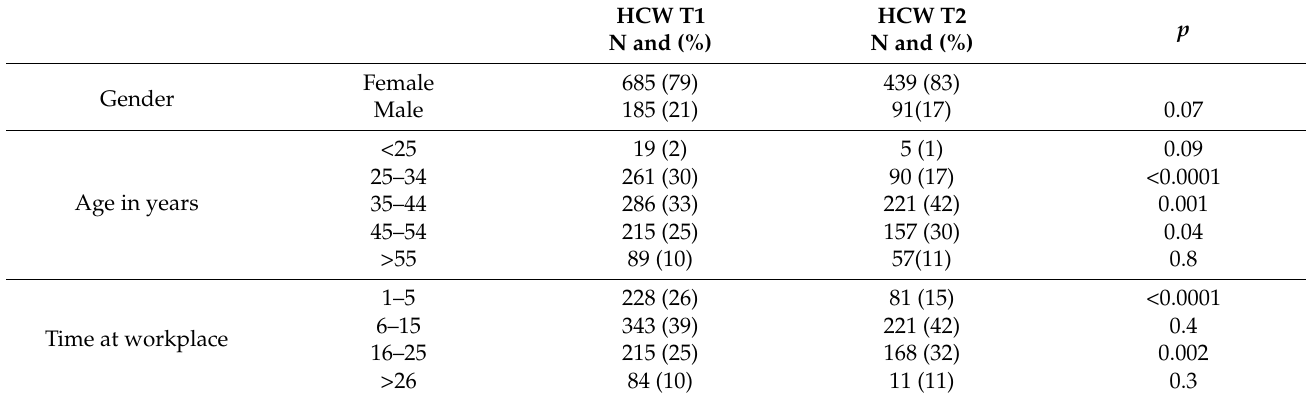
Table 3. Comparisons between T1 and T2 for HCWs.